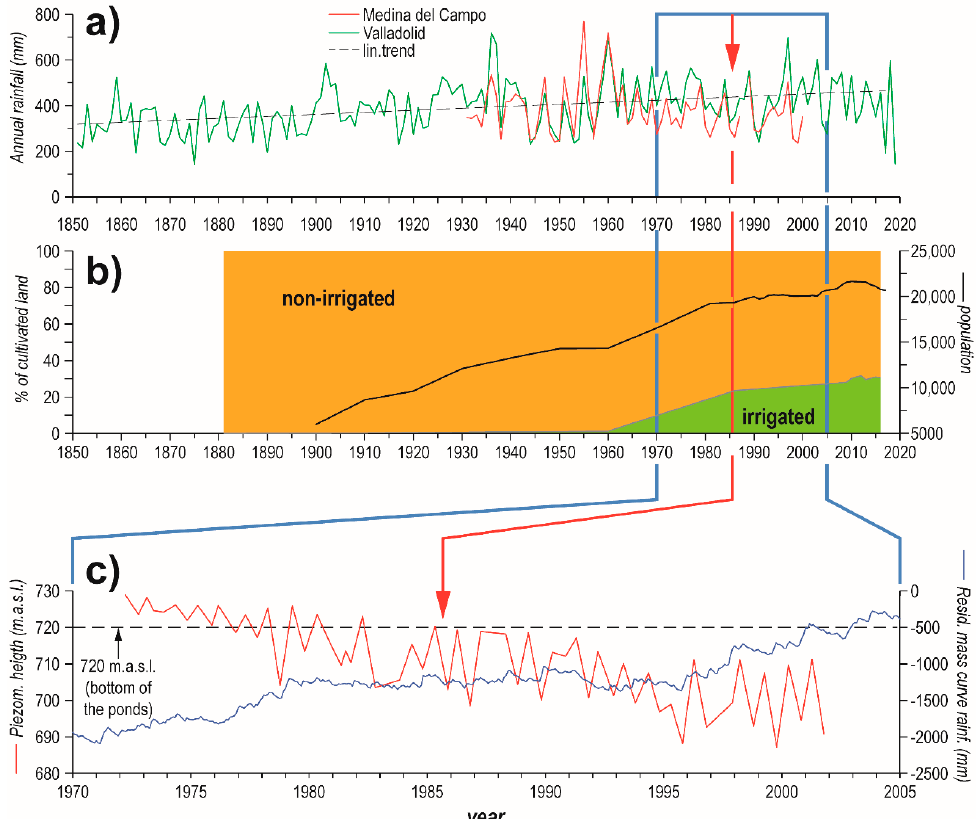
Figure 2. Climate, population, land-use and water-level evolution. ( a ) Annual rainfall series for the Valladolid and Medina del Campo weather stations (AEMET); ( b ) population (INE) and percentage of irrigated vs. non-irrigated cultivated area (Chamber of Agriculture of Medina del Campo); ( c ) piezometric height for water point 1517-4-0002 (IGME) (base level 730 m a.s.l., depth: 140 m) and the residual mass curve for rainfall for the 1971–2001 period. This period is bracketed by a blue line in panels ( a , b ). The fall in1985 is marked by a red arrow in the three panels.